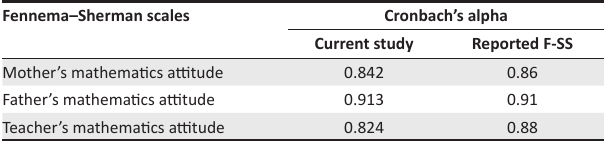
TABLE 4: Reliability statistics for the variables. Fennema–Sherman